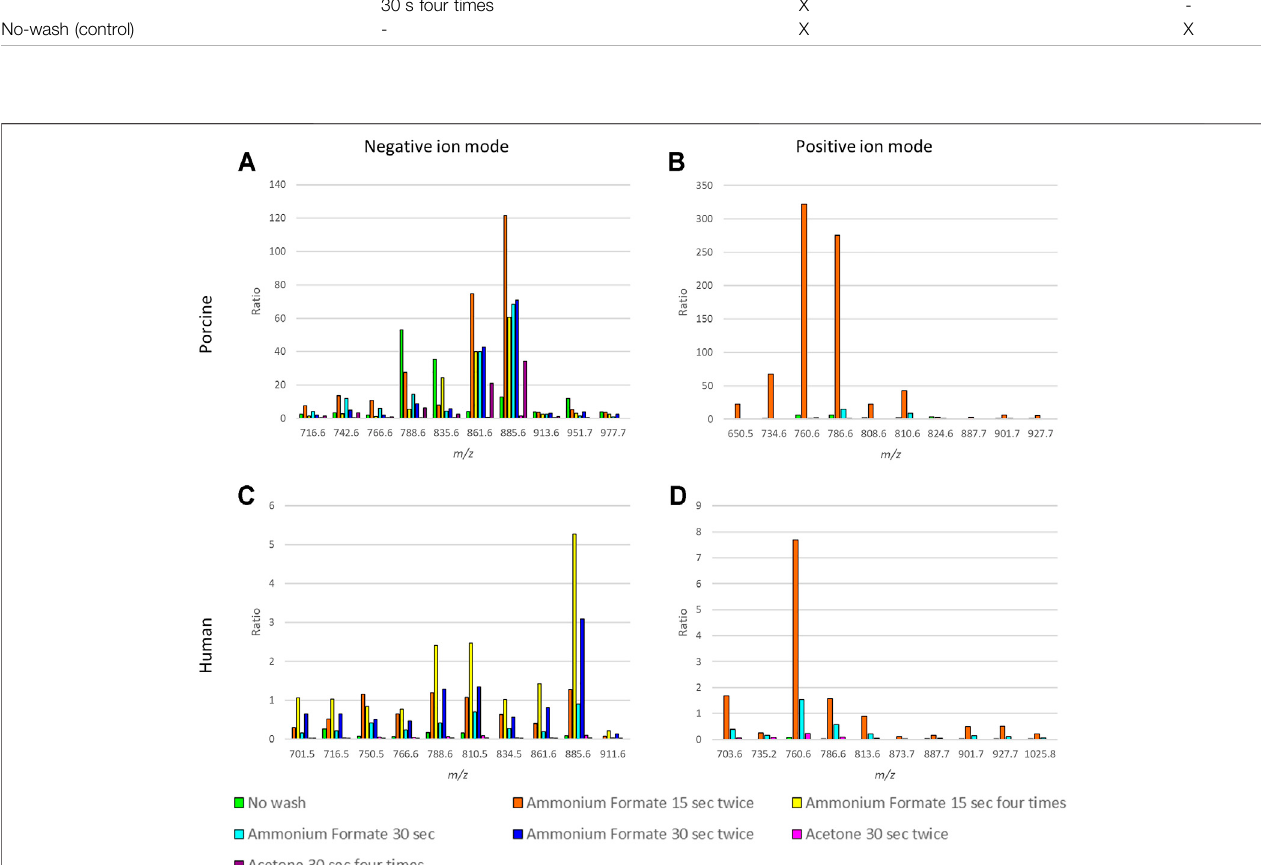
FIGURE 2 | Comparison of the ratios between heme and selected m/ z values for different washing methods for negative and positive ion mode for porcine and humanfracturehematoma.Theratiosrepresent theionintensitiesofselected m/z valuesoverthehemeionintensity.The m/z valueswereselectedbasedonthehighest intensities(excludingisotopes)andtocoverthemassrangeoflipids( m/z 650 – 950). (A) Ratiosfor10 m/z valuesforthesixwashingmethodsandthecontrol(nowashing) for porcine fxh in negative ion mode. (B) Ratios for 10 m/z values for the three washing methods and the control (no washing) for porcine fxh in positive ion mode. (C) Ratios for 10 m/z values for the six washing methods and the control (no washing) for human fxh in negative ion mode. (D) Ratios for 10 m/z values for the three washing methods and the control (no washing) for human fxh in positive ion